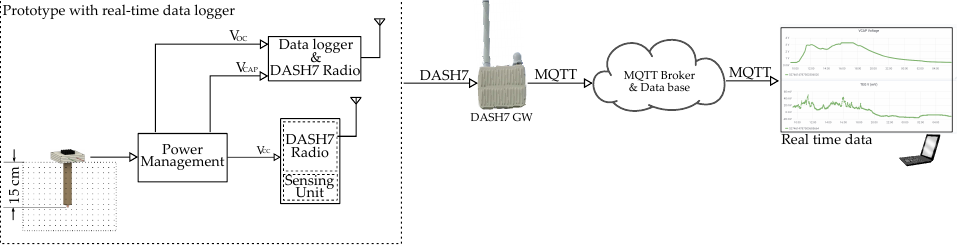
Figure 10. A block diagram of the complete experiment setup with harvester, data-logger and real-time data on a